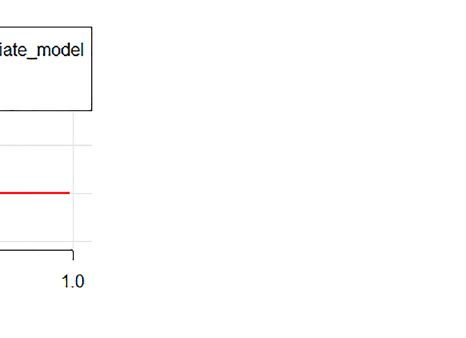
Figure 4. Decision curve analysis for the multivariate model based on regression analysis in the validation cohort. The y-axis indicates the net benefit; x-axis indicates threshold probability. The multivariate model (red line) had the highest net benefit compared with the simple diagnoses such as all HER2-positive GC patients (blue line) or all HER2-negative GC patients (black line) across the majority of the range of reasonable threshold probabilities at which a patient would be diagnosed as